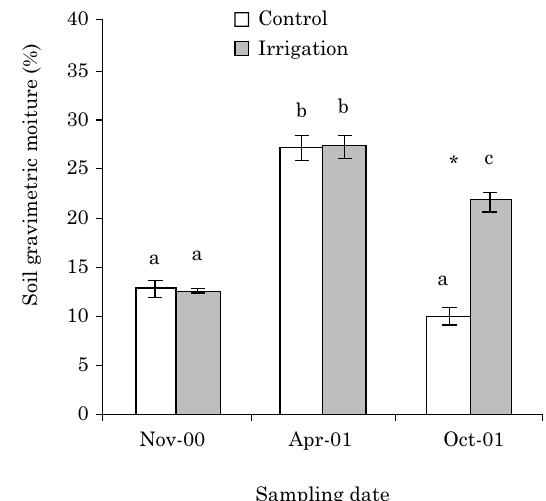
Figure 2. Soil gravimetric moisture under 15-year-old secondary vegetation (n=12) according to the sampling date and irrigation; * indicates a significant difference between irrigation treatments; means followed by the same letters, for each irrigation treatment, do not differ by Tukey’s test at 5 %. Vertical bars represent the standard